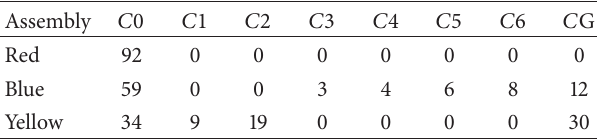
Table 1: Number of fuel bars of type 𝐶𝑋 ( 𝑋 = 0, ...,6, G) for each assembly. There are a total of 92 bars for each assembly.